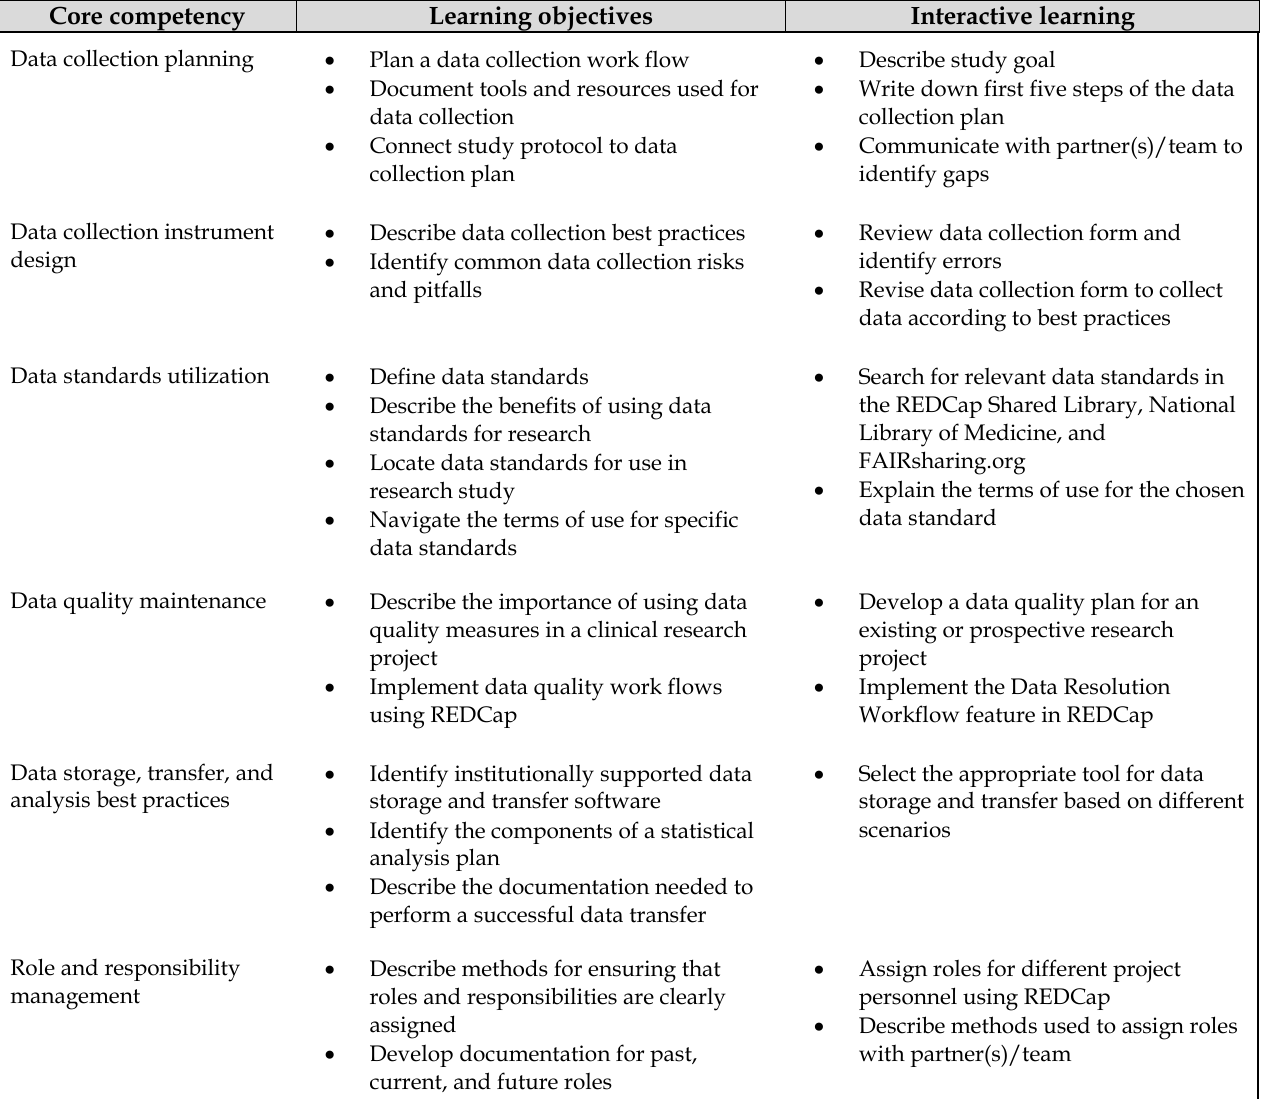
Table 1 Clinical research data management workshop core competencies Core